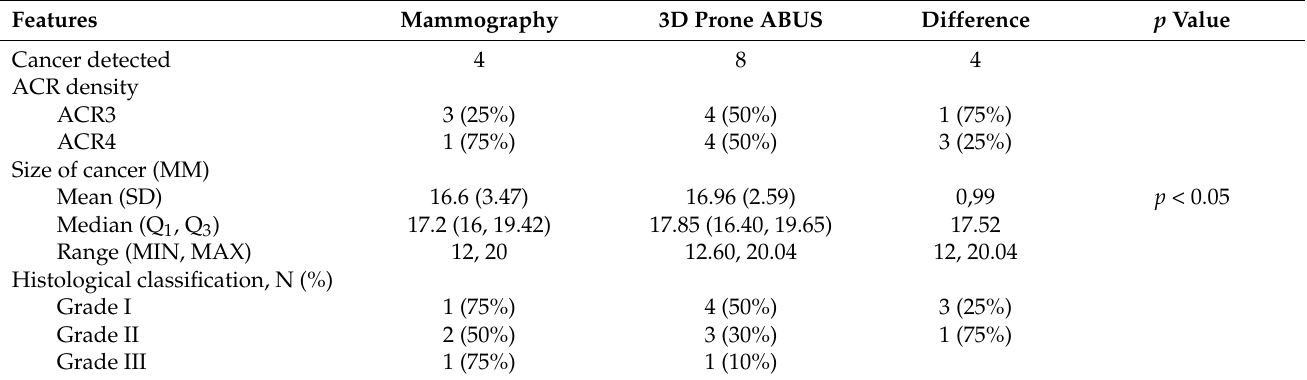
Table 2. Mammography and 3D prone ABUS breast cancer detection.